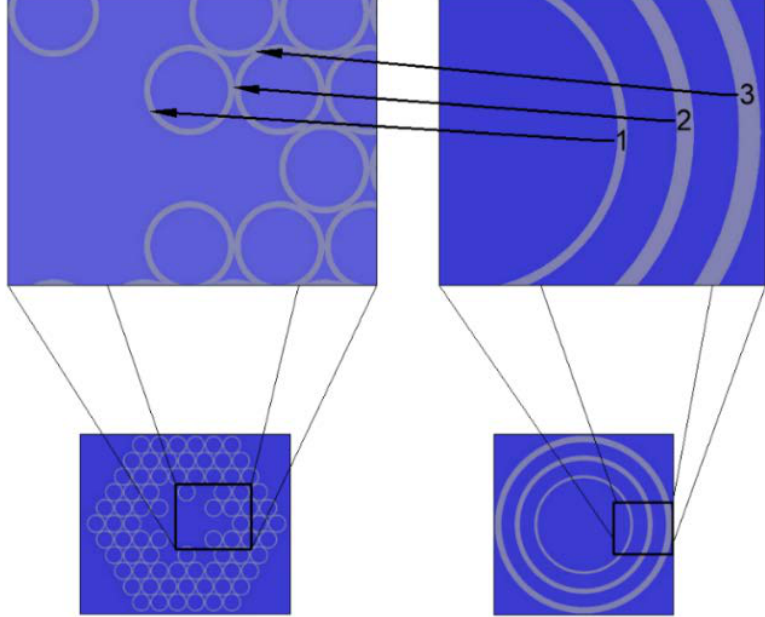
Figure 8. Star structure ( bottom left ) approximated by a triple ring structure ( bottom right ). Each of the glass rings has its wall thickness corresponding to the thickness of the glass element of the star structure, as pointed by the arrows. Consequently, 1 = d 0 = 0.54 µm, 2 = a = 0.98 µm and 3 = b = 1.24 µm, which corresponds to the outer radius ( R out ) of a single glass capillary in the star structure being 3.85 µm.